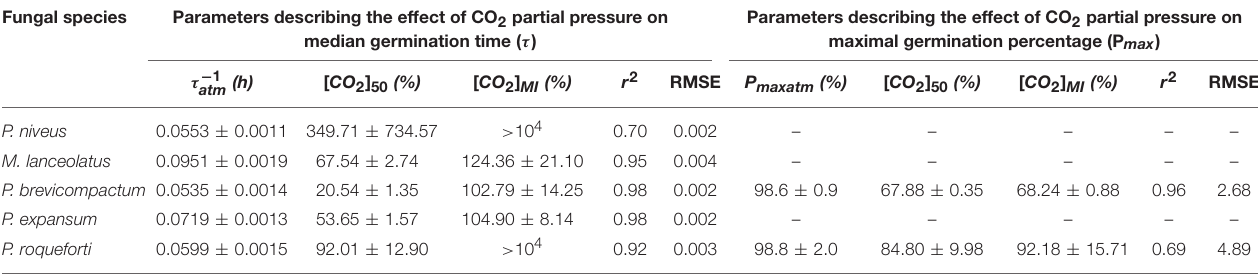
TABLE 3 | Secondary model parameters ± standard deviation obtained by fitting Equation (4) to reciprocal of median germination times τ − 1 (h − 1 ) or maximum germination percentages P